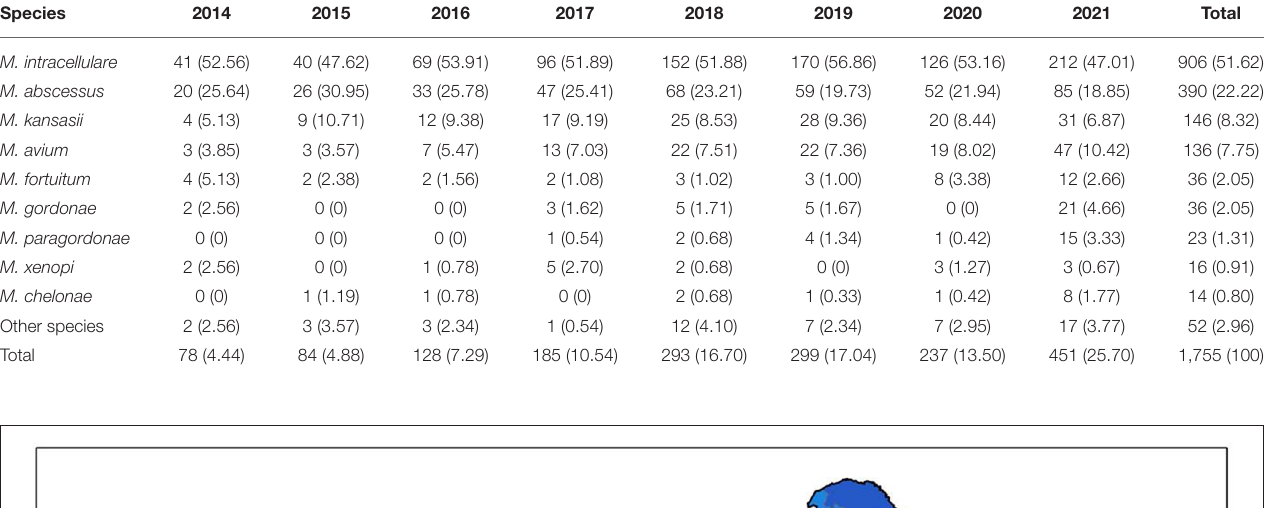
TABLE 2 | Non-tuberculous mycobacteria species isolated from respiratory specimens in China, 2014–2021. Species